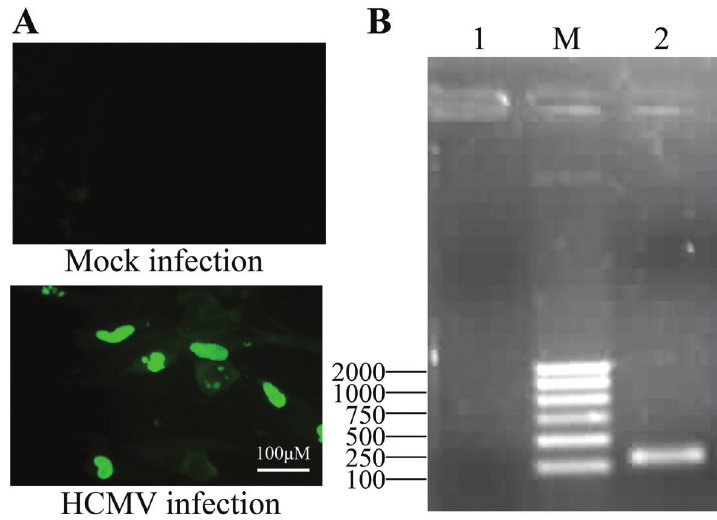
when compared with mock-infection group (Figure 2A). The results of western blot also showed that HCMV infection inhibited the expression of SSBP1 from 24 to 96 h (Figure 2B), indicating that HCMV infection down- regulated SSBP1 in a time-dependent manner.